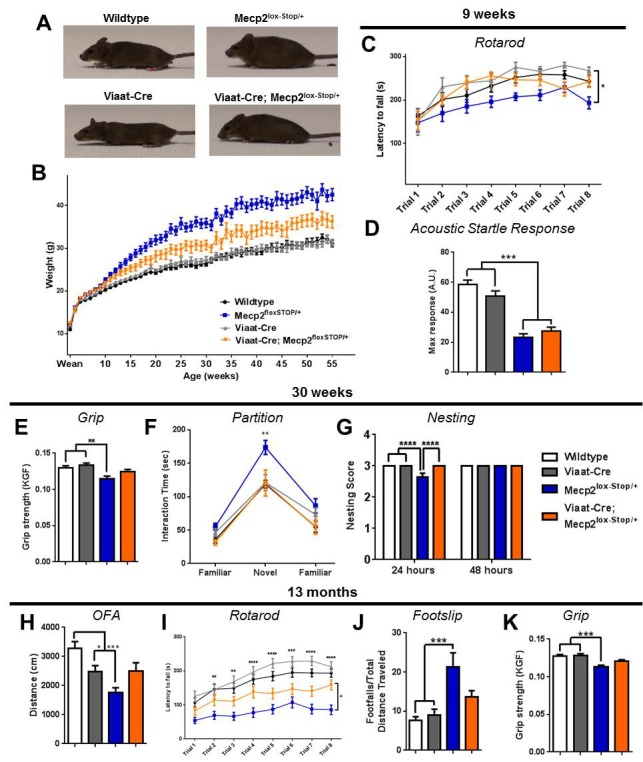
Female rescue mice exhibited a partial but sustained functional recovery.(A) Female rescue mice appeared grossly normal at 23 weeks of age. (B) Female rescue mice body weight was partially rescued (n = 27–37 per genotype). (C) Female rescue mice performed better at 9 weeks of age on the accelerating rotarod than Mecp2lox-STOP/+ females, but not to wildtype levels (n = 14–16 per genotype). (D) Acoustic startle response at 9 weeks of age was not rescued (n = 14–17 per genotype). (E–G) At 30 weeks of age, female rescue mice showed partial rescue of grip strength (E) and complete rescue of hypersociability in the partition test (F) and nesting ability (n = 13–18 per genotype) (G). (H–K) Rescue females exhibited a partial but sustained rescue of locomotion in the open field (H), rotarod (I), footslip (J), and grip strength (K) assays (n = 20–35 per genotype). Error bars show SEM. *p<0.05 **p<0.01 ***p<0.001 ****p<0.0001.